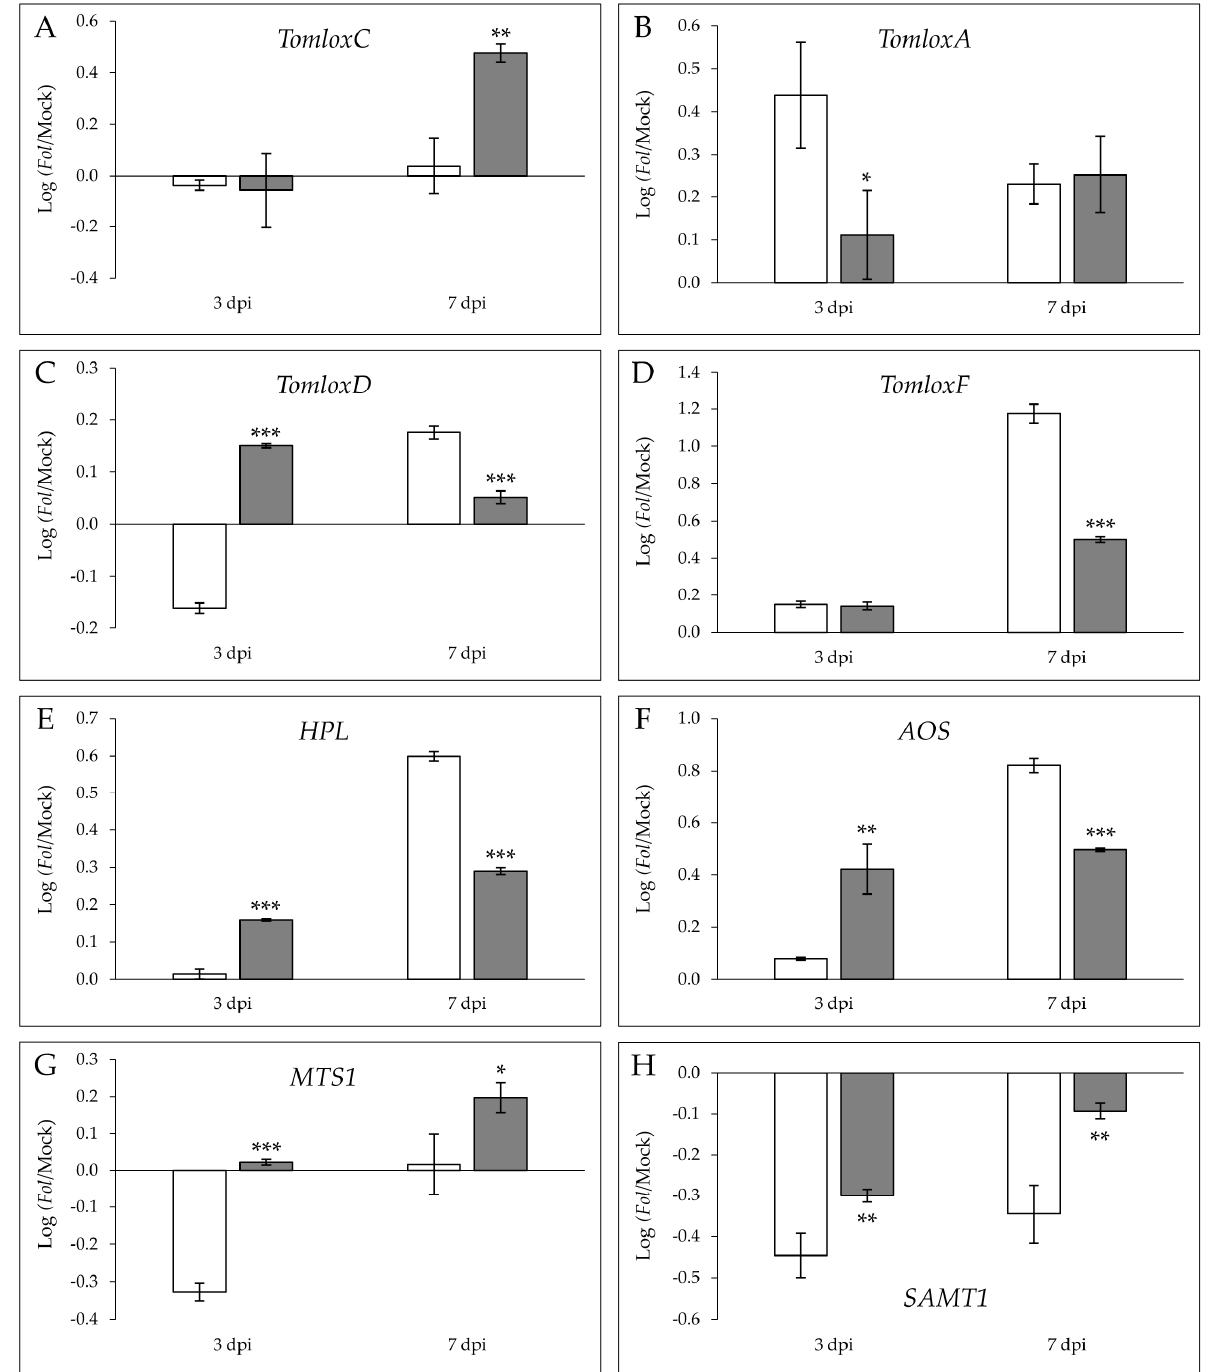
Figure 5. Logarithm of the ratios of the relative expression levels between Fol -infected and mock-inoculated leaves of TomloxC ( A ), TomloxA ( B ), TomloxD ( C ), TomloxF ( D ), HPL ( E ), AOS ( F ), MTS1 ( G ), and SAMT1 ( H ) in susceptible Momor (MOM; white) and resistant Movione (MOV; gray) tomato plants upon Fusarium oxysporum f. sp. lycopersici infection at 3 dpi and 7 dpi by RT-qPCR. cDNA expression levels were expressed as the average log(ratio) values of a representative experiment. Values were expressed in relation to the endogenous gene, elongation factor 1 α . Statistical analysis was done by means of a t- test or a Mann–Whitney test. Asterisks (*) mean p < 0.05 (*), p < 0.01 (**), and p < 0.001 (***). A significant induction of the relative expression levels was observed for TomloxA at 3 dpi (Figure 5B), as well as for TomloxF (Figure 5D) and HPL (Figure 5A) at 7 dpi in